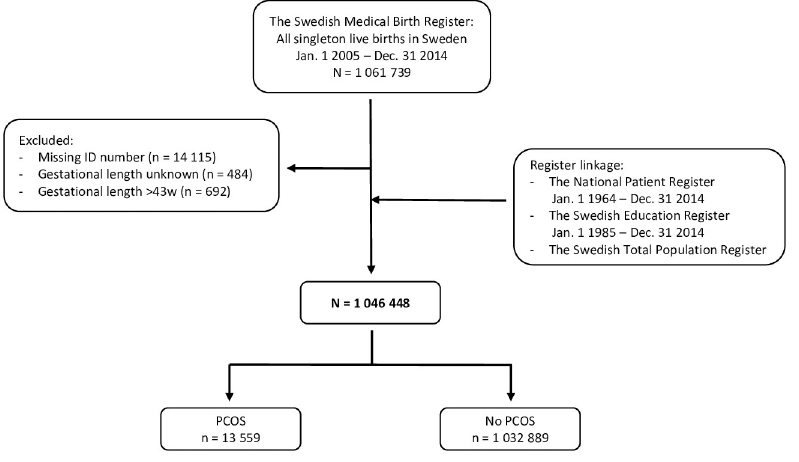
Fig 1. Flowchart of the study